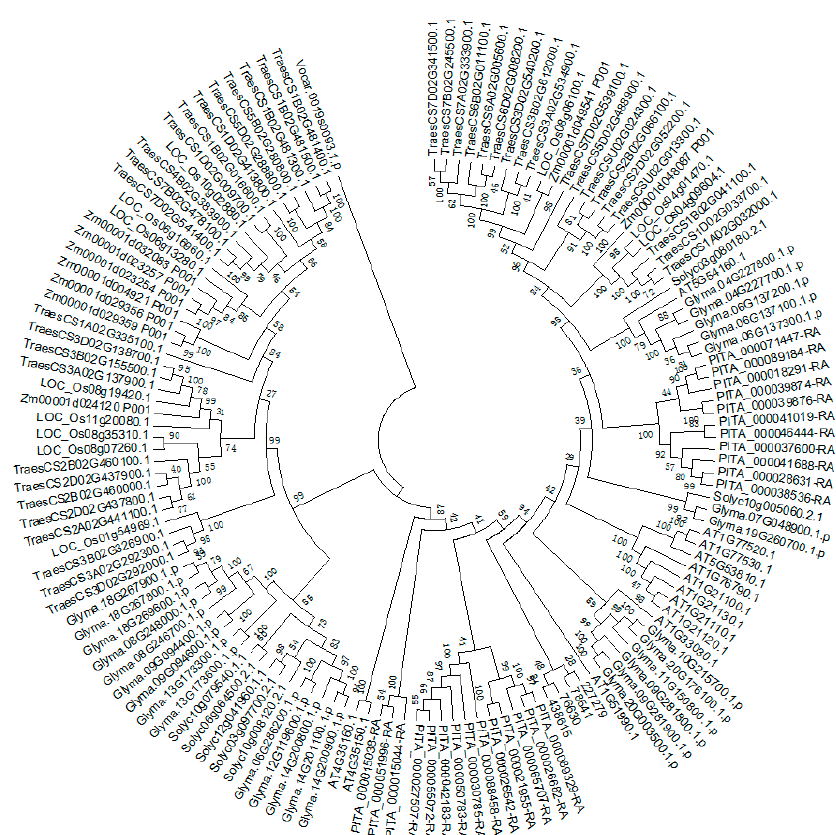
Figure 2. Phylogenetic relationship of the N-acetylserotonin methyl-transferase ( ASMT ) genes from 10 plant species. The 10 plant species include A.thaliana , S.lycopersicum , G.max , Z.mays , O.sativa , T.aestivum , P.taeda , S.moellendorffii , P.patens, and algae.